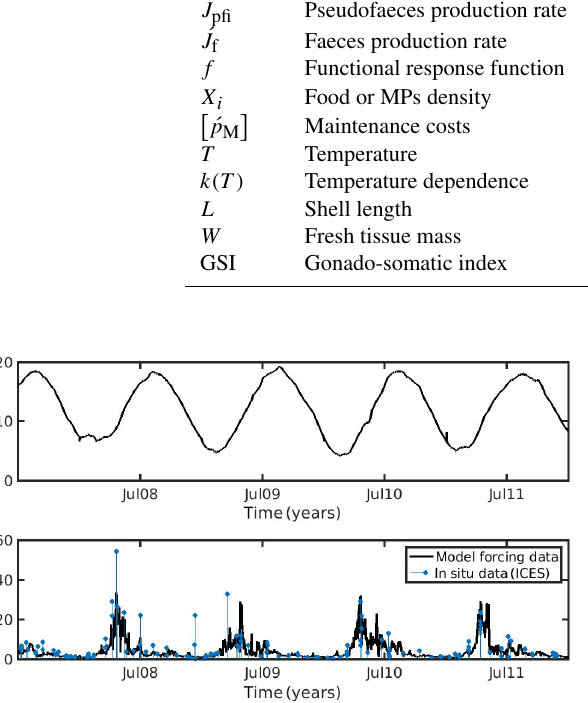
Figure 1. Environmental data used for the forcing of the dynamic energy budget model (DEB) in the North Sea simulation, showing (a) temperature and (b) chlorophyll a concentration against in situ data from the ICES